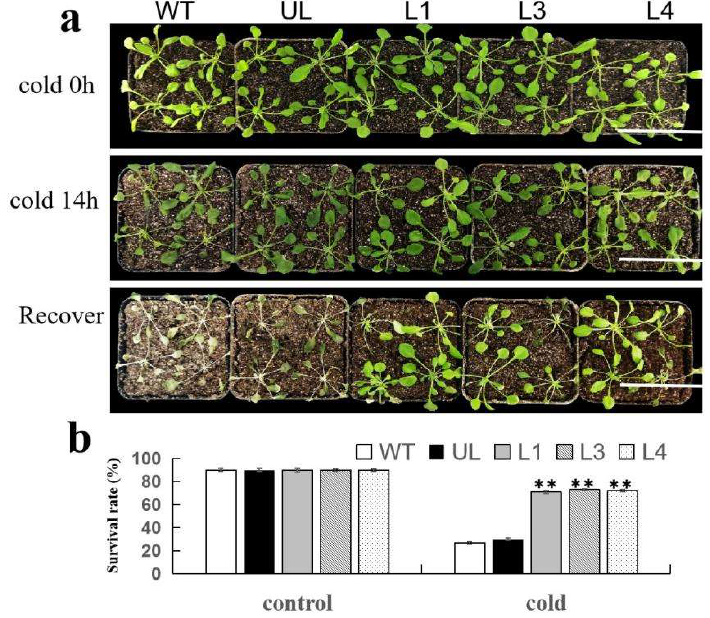
Figure 7. Transgenic A. thaliana that is overexpressing FvMYB44 grows when kept at low temperatures. ( a ) Phenotypes of WT, UL and FvMYB44 overexpression lines (L1, L3, and L4) under control conditions (22 ◦ C), after exposure to low temperature ( − 8 ◦ C) and one week after resumption of growth. Bar = 5 cm. ( b ) The percentage of WT, UL, and transgenic lines that survived in a control condition and after being exposed to cold. Three replicate experiments were conducted. The standard deviation is indicated by error bars. Significant differences between the WT and UL, transformed lines are denoted by asterisks (** p ≤ 0.01).